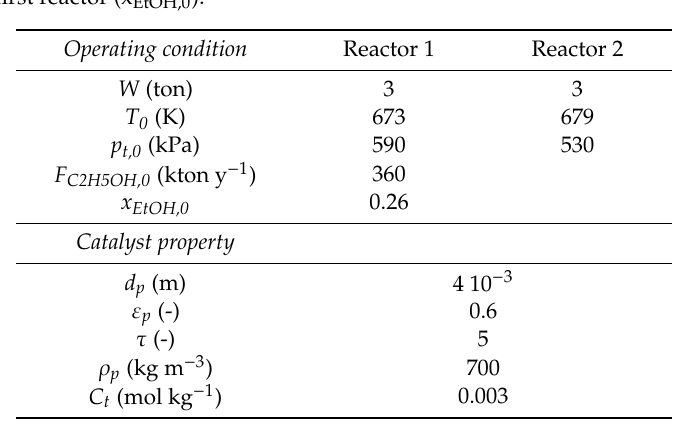
Table 3. Experimental operating conditions: catalyst mass (W t ), inlet temperature (T 0 ), and pressure (p t,0 ) for each adiabatic reactor and the annual ethene production capacity (G C2H4 ) and inlet water content for the first reactor (x EtOH,0 ).